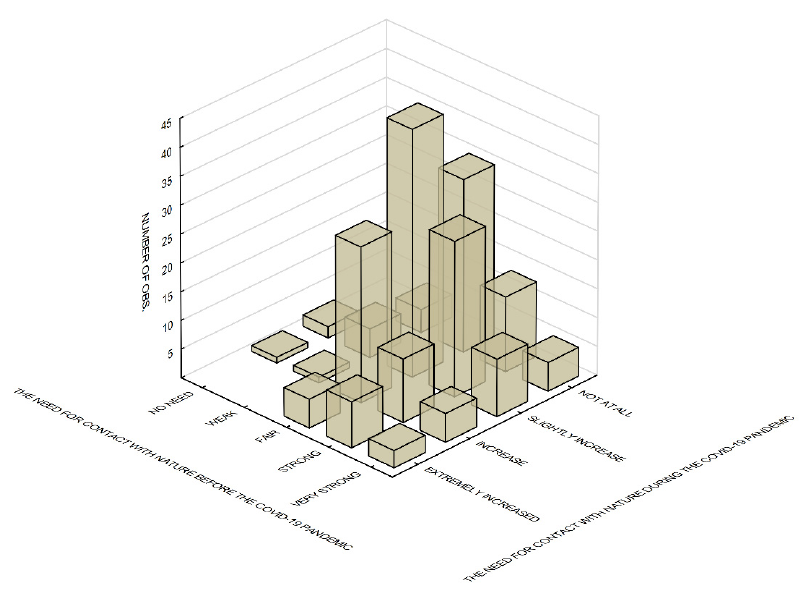
Figure 8. The need for contact with nature before and during the COVID-19 pandemic.